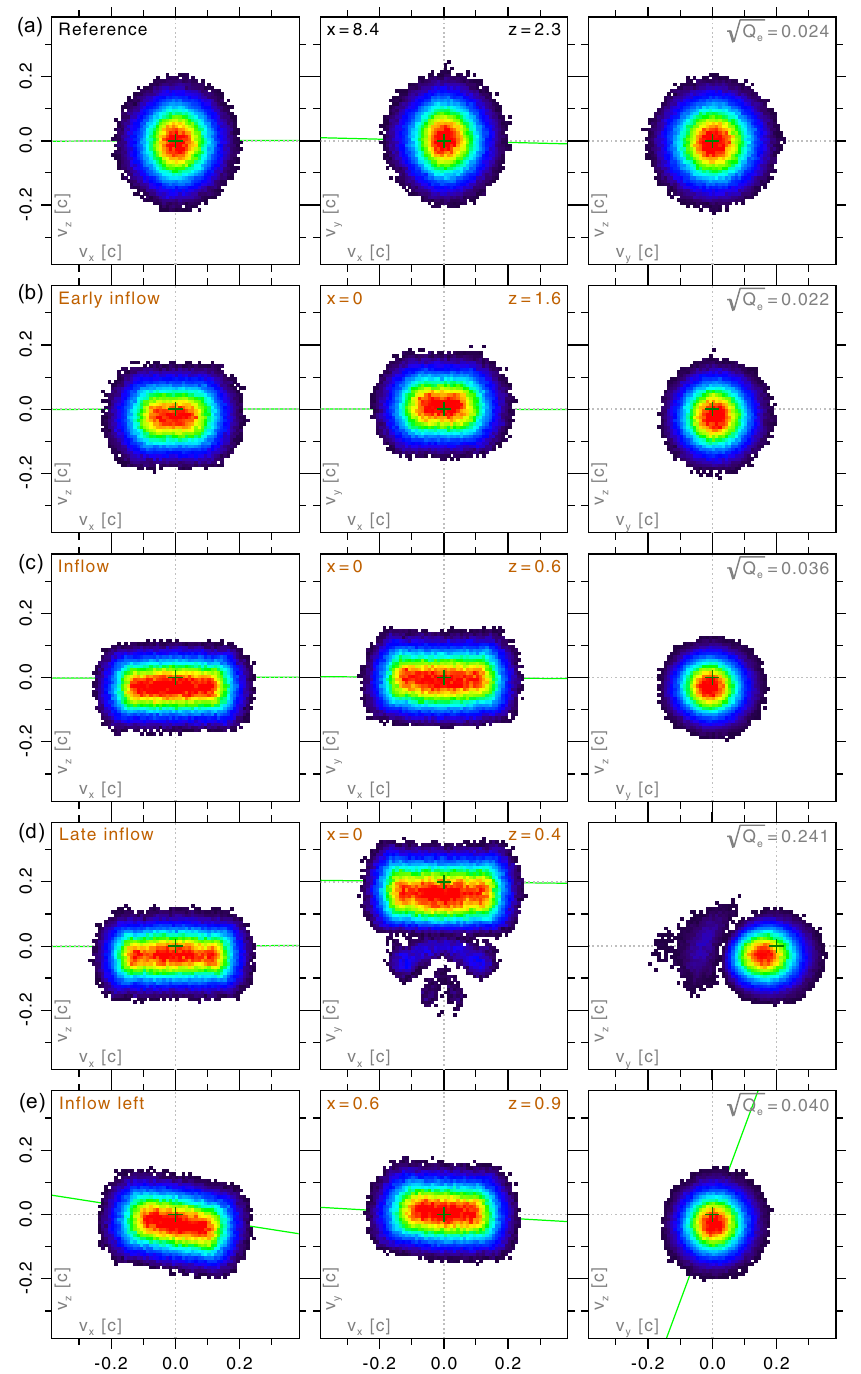
Figure 5. Electron velocities distribution functions (2-D cuts) for the reference area and the inflow region. The gray dotted line indicates v = 0 and the text label color indicates the analysis area positions from Fig. 2. The z coordinates are given in d i while x coordinates are given in negative d i ; see the top of the panels in the middle column. The color code shows the probability distribution on a linear scale, where saturated red indicates the 90% level of the maximum value within each panel. The green lines indicate the mean magnetic-field direction in those cases in which there is a significant